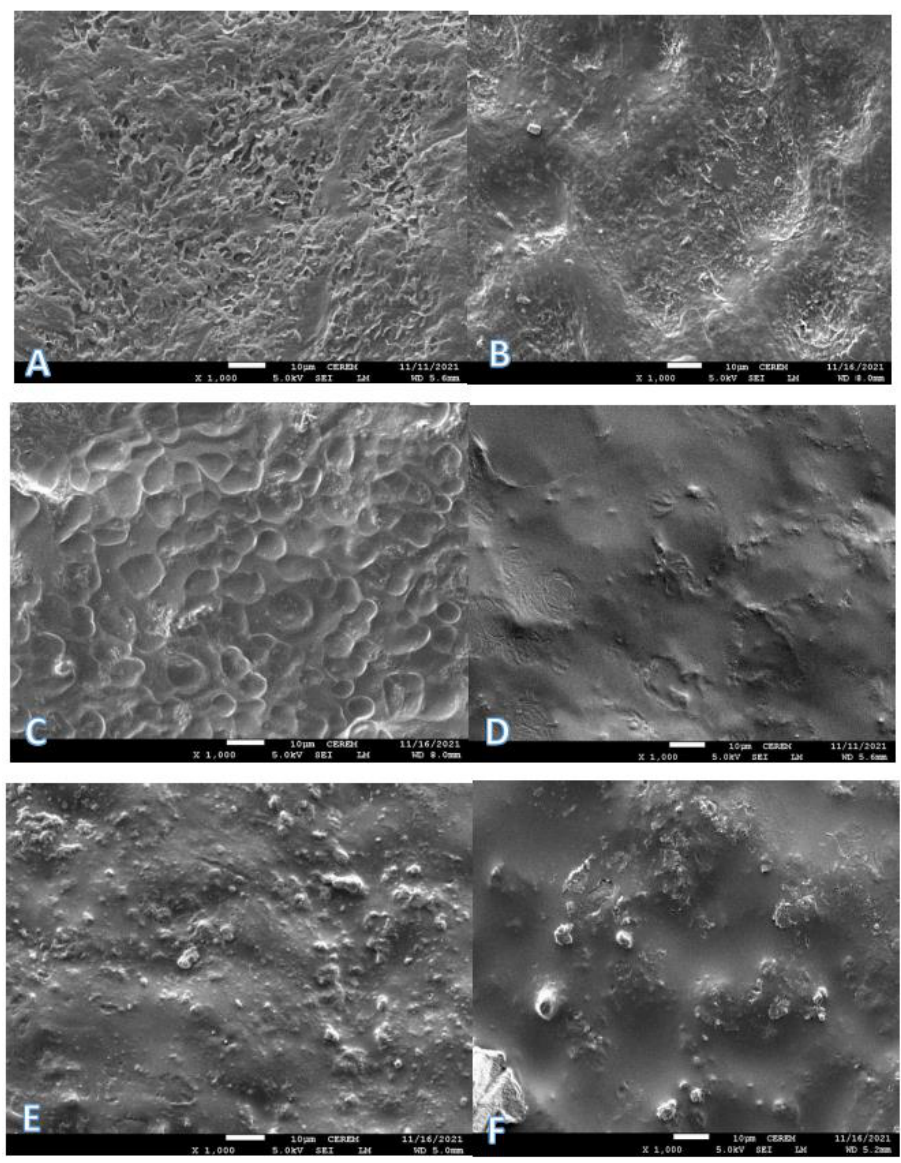
Figure 2. Scanning electron microscopy images (resolution ×1000) of Barhi date surfaces when fresh ( A ) and coated using 2% chitosan ( B ), 1% olive cake extract and 2% chitosan ( C ), 2% olive cake extract and 2% chitosan ( D ), 1% orange peel extract and 2% chitosan ( E ), and 2% orange peel extract and 2% chitosan ( F ).